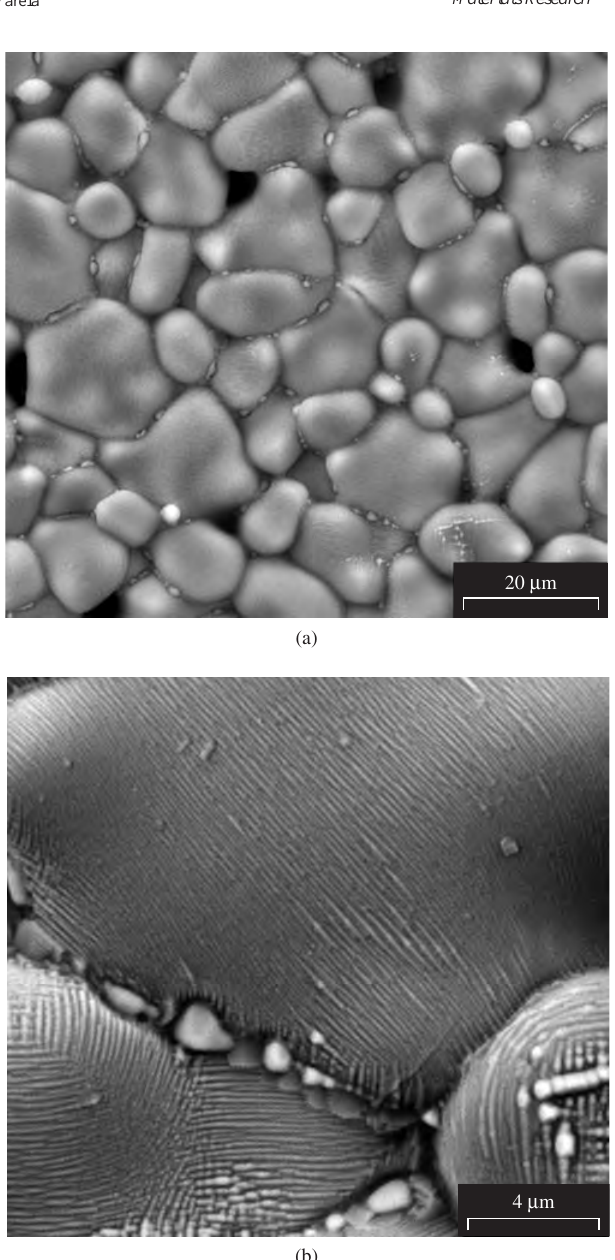
Figure 6. These SEM microgra�hies ill�strate the s�i�odal decom�ositio� of the solid sol�tio� �etwee� TiO a�d S�O . Both crystallize i� the r�tile 2 2 str�t�ct�re, a�d form a com�lete solid sol�tio� a�ove 1400 °C. However, at lower tem�erat�res there is �early symmetric immisci�ility ga� ce�tered at ~50% of each com�o�e�t. As a res�lt, s�i�odal decom�ositio� ca� occ�r ��o� cooli�g TiO a�d S�O solid sol�tio�s, the early stages of which are 2 2 characterized �y se�aratio� i�to Ti-rich a�d S�-rich, lathe-like regio�s orie�ted i� s�ecific crystallogra�hic directio�s 52,54,55